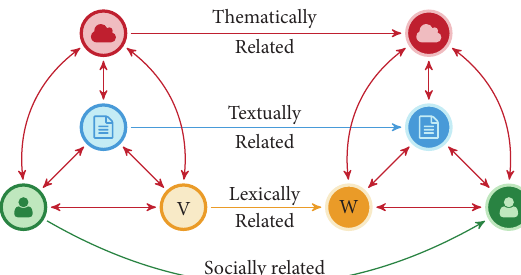
Figure 11: Schematic depiction of informational sources explored to link topics (red vertices) in a 3-level topic network as a function of the textual relatedness of texts (blue vertices) (belonging to layer L of Definition 1), the social relatedness of corresponding authors (green 1 of Definition 1), and the lexical relatedness of corresponding words (orange vertices) (belonging to layer L vertices) (belonging to layer L 2 Definition 1). In this scenario, thematic relatedness is the information to be inferred, while textual, lexical, and social relations concern given information or evidence. Bidirectional red arcs denote arcs of corresponding margin layers of Definition 1.